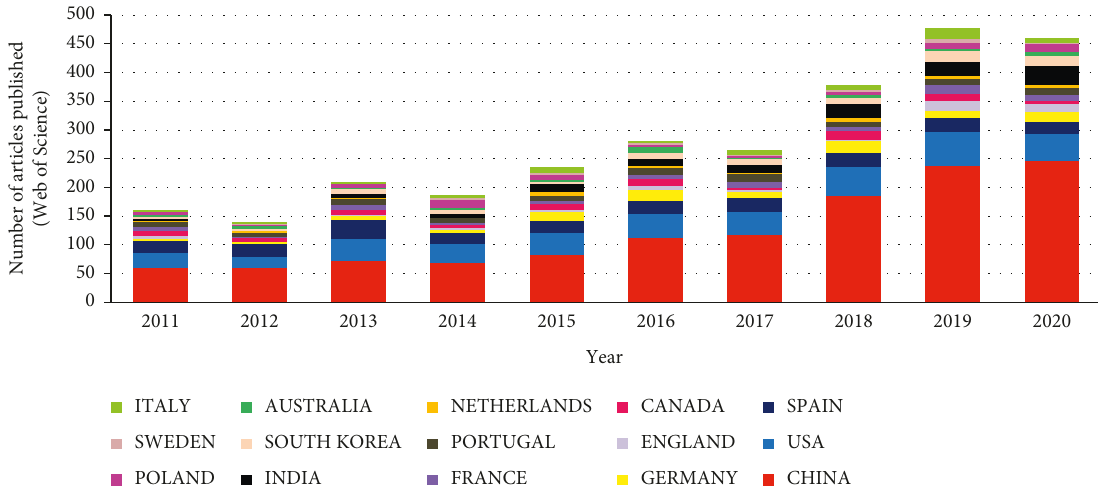
Figure 1: Research publications on antibiotic detection in water in the last decade (2011–2020). Source: Web of Science (https://www. Figure 1 were indexed on the Web of Science using the keyword “detection of antibiotics in water,” and then the results were classified using the filters “year” and “country/ region.”